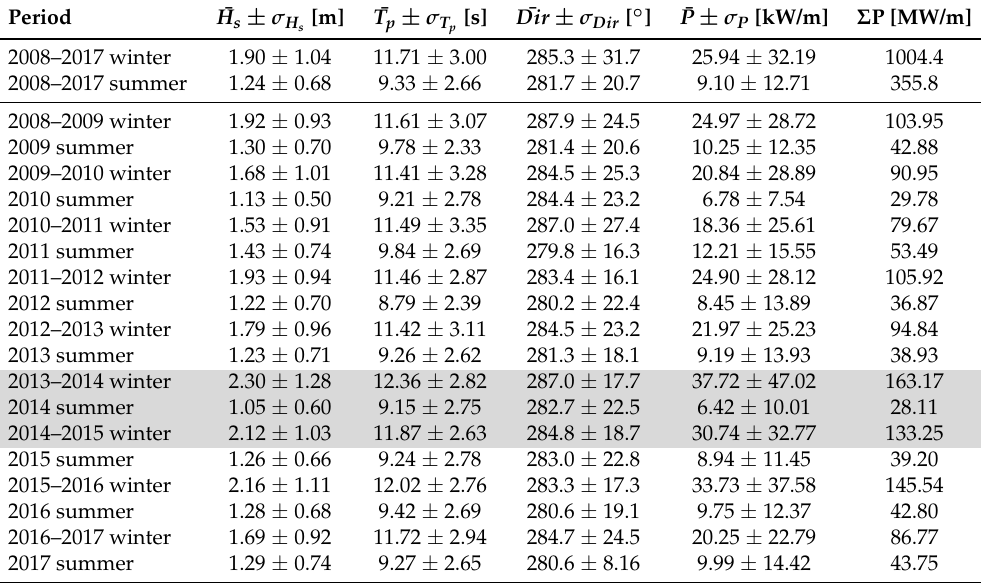
Table A2. Seasonal (winter–summer) wave statistics from 2008–2017. The same notations have been used as in Table A1. The grey-highlighted rows illustrates the morphological time-frame